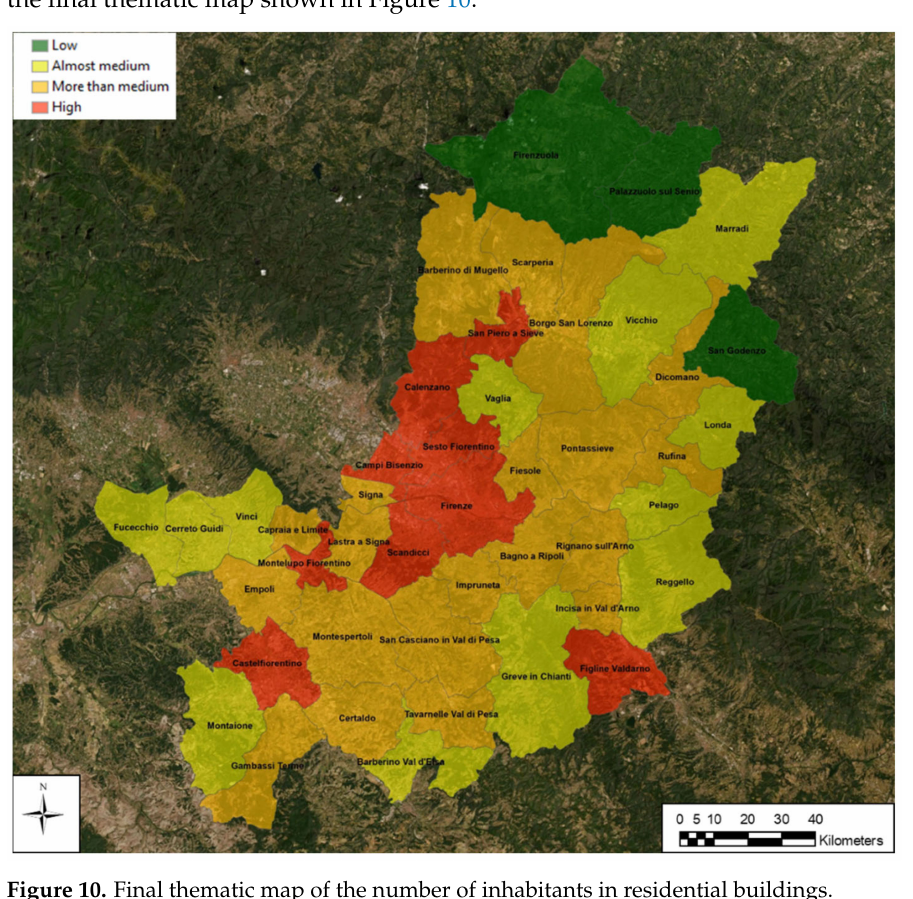
Figure 10. Final thematic map of the number of inhabitants in residential buildings. The fuzziness H( F ) of the final fuzzy partition, computed by (7), is 0.32 and the reliability of the thematic map in Figure 10 is